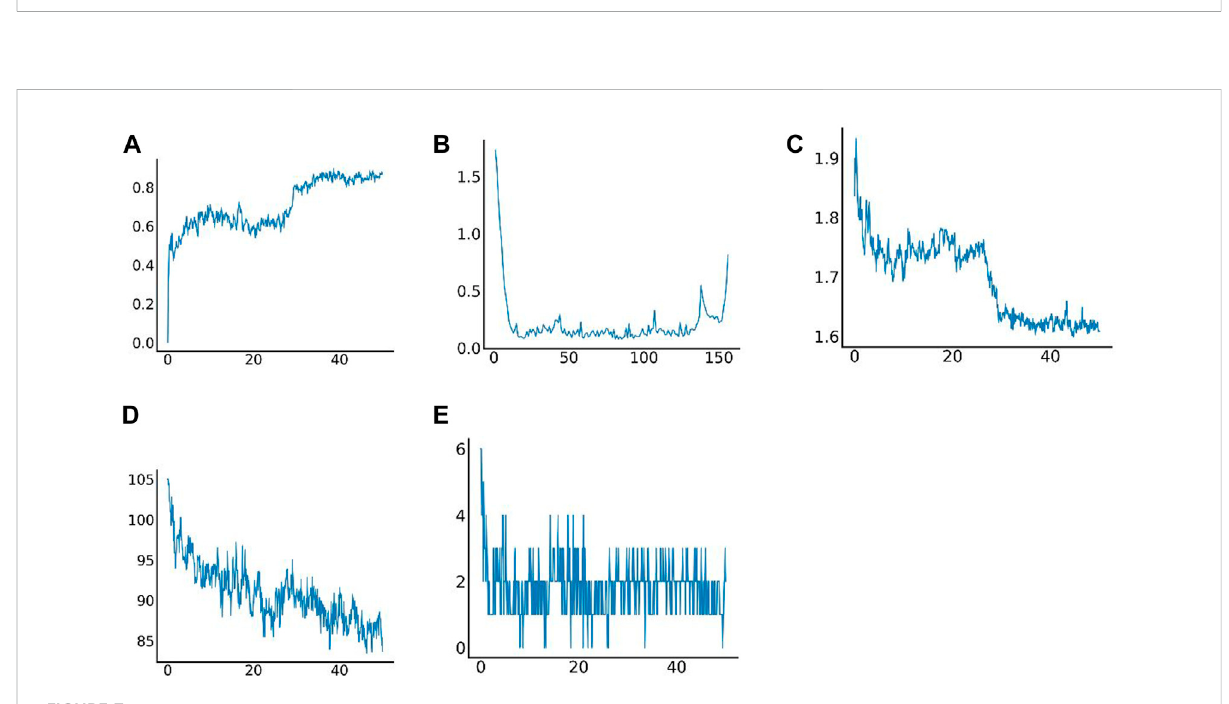
Resultsofmoleculardynamicssimulation. (A) Root-mean-squaredeviation(RMSD)ofcomplexMDS; (B) Root-mean-square fl uctuation(RMSF) of complex MDS; (C) Variations in the radius of gyration (Rg) of complex MDS; (D) Variations in SASA of the protein in 0 – 100 ns of complex MDS; (E) Variations in hydrogen bonding in the stable